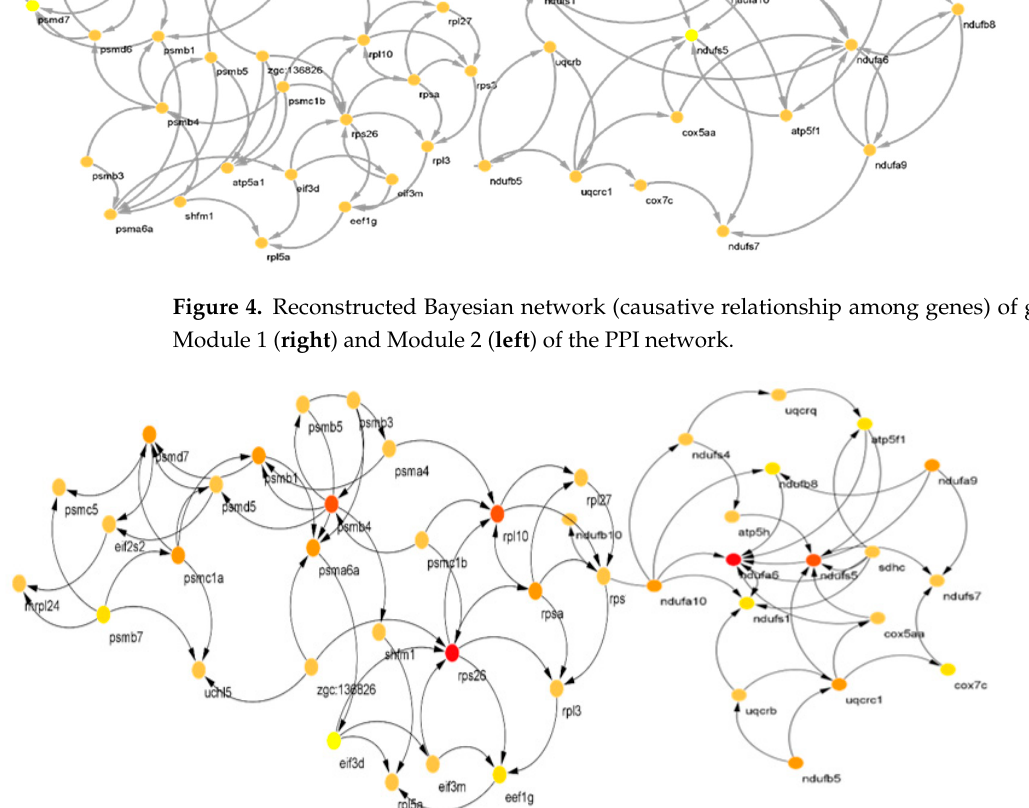
Figure 4. Reconstructed Bayesian network (causative relationship among genes) of genes within Module 1 (right) and Module 2 (left) of the PPI network.